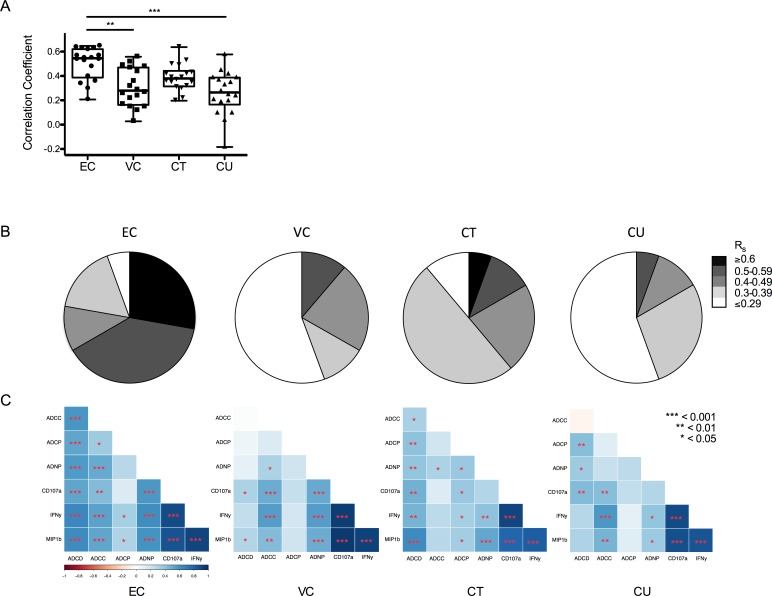
Functional coordination within HIV-infected subject groups.
A. The extent of functional coordination within groups was assessed by calculating Spearman’s rank correlation coefficients across each pair of independently assessed functional assays. Differences between subject groups were evaluated using a Friedman ANOVA corrected for multiple comparisons using Dunn’s Test in Graphpad Prism. B. Prevalence of functional correlations by strength for each subject group. C. Correlation matrix for each pairwise combination of functions tested, in which strong positive correlations appear blue while inverse correlations appear red, for each subject group. Correlative relationships and significance were calculated and visualized using R, with unadjusted p values indicated to facilitate relative comparisons.